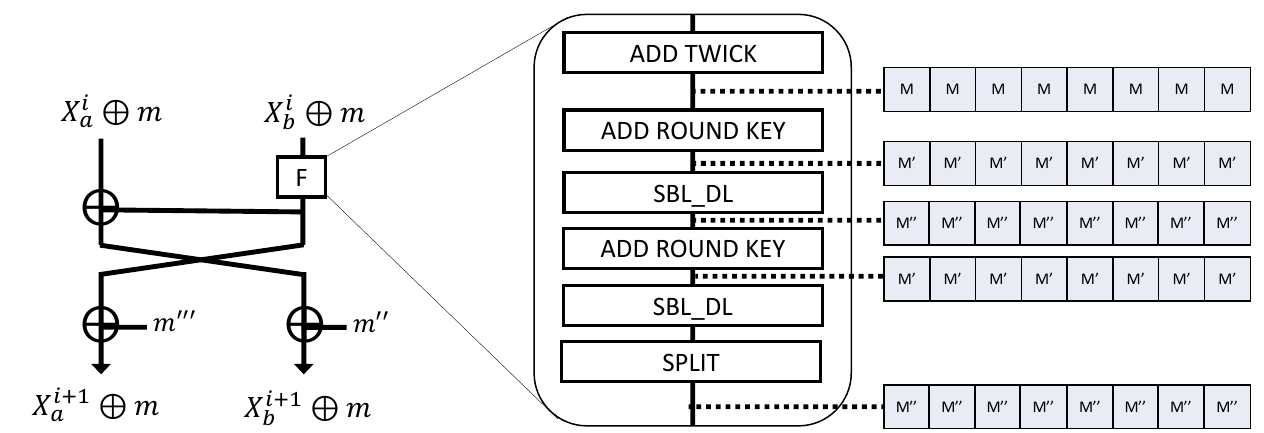
Figure 7. Masking implementation using SBL-multiplication